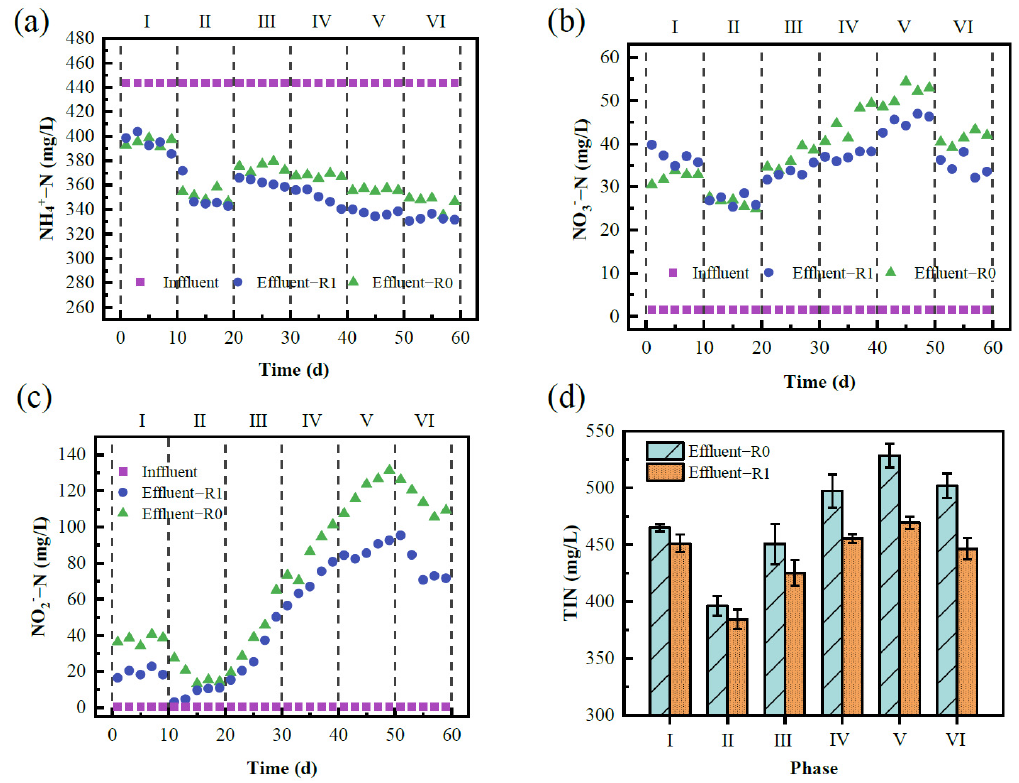
Figure 2. Removal performances of reactors for NH 4+ -N ( a ), NO 3 − -N ( b ), NO 2 − -N ( c ) and TIN ( d ) at each phase under different aeration rates.